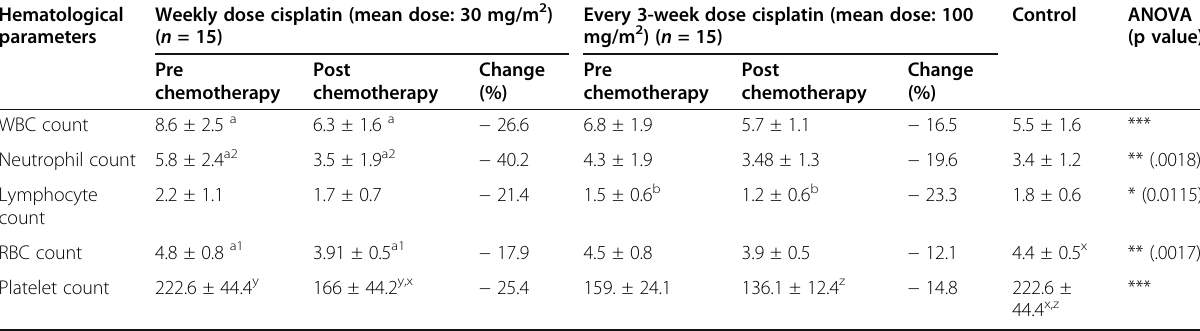
Table 2 Hematological parameters of LA-SCCHN patients in both the groups Hematological